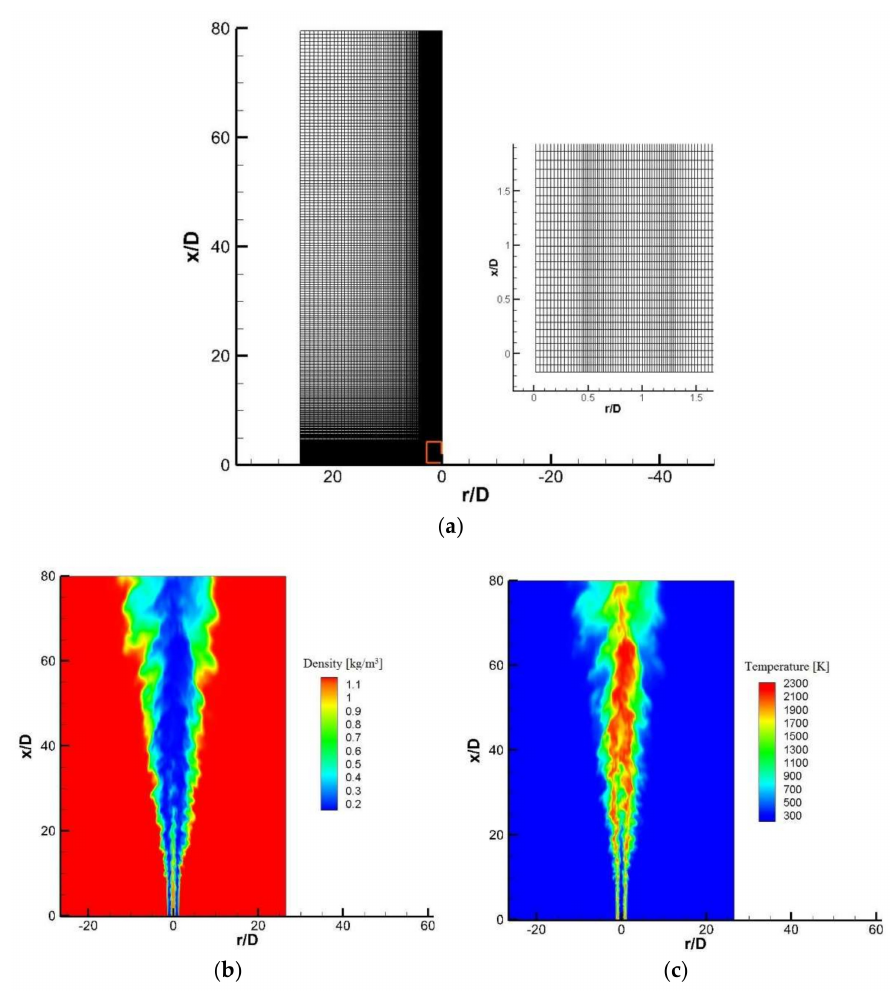
Figure 5. ( a ) Computational grid and ( b ) instantaneous view of the density, and ( c ) instantaneous view of the